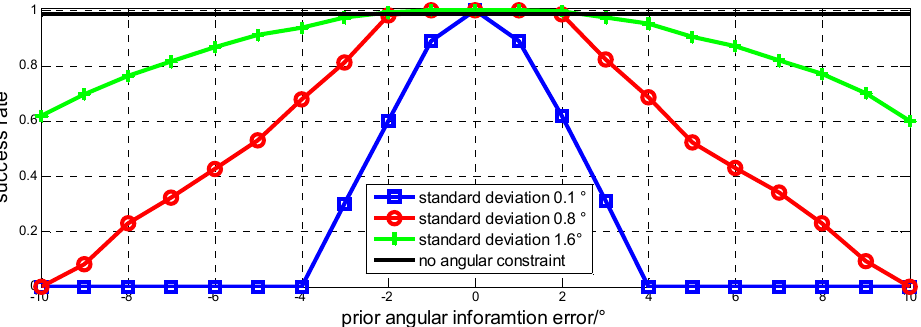
Figure 3. Prior angular information error affects success rate of ambiguity fix, heading as example.